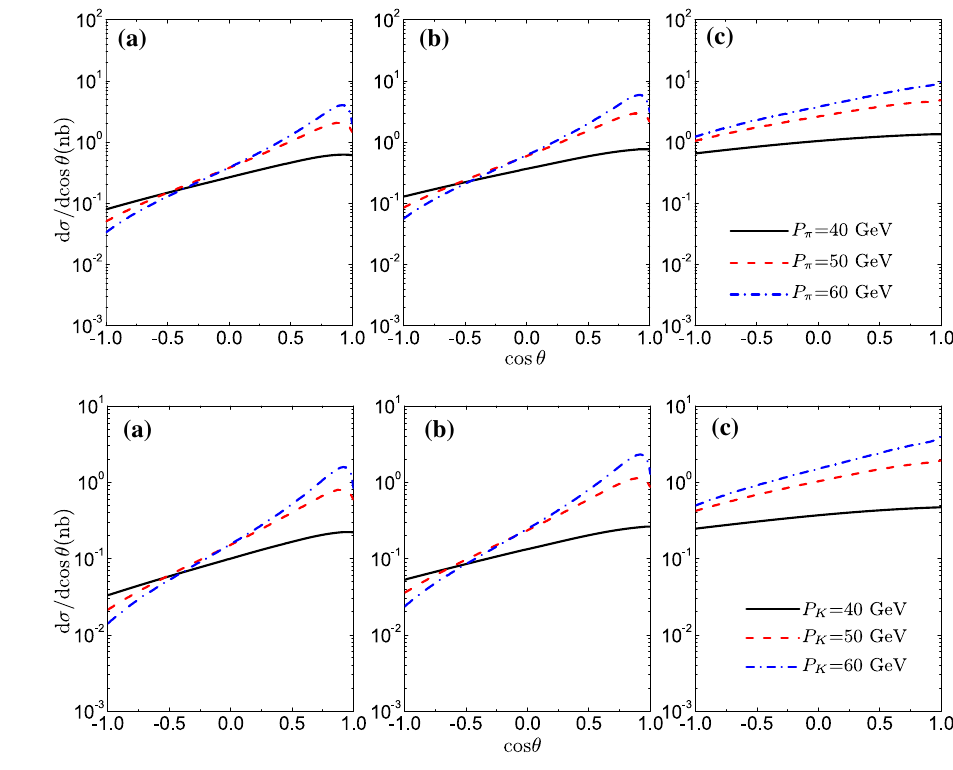
Fig. 5 The same as Fig. 2 but for differential cross sections depending on cos θ